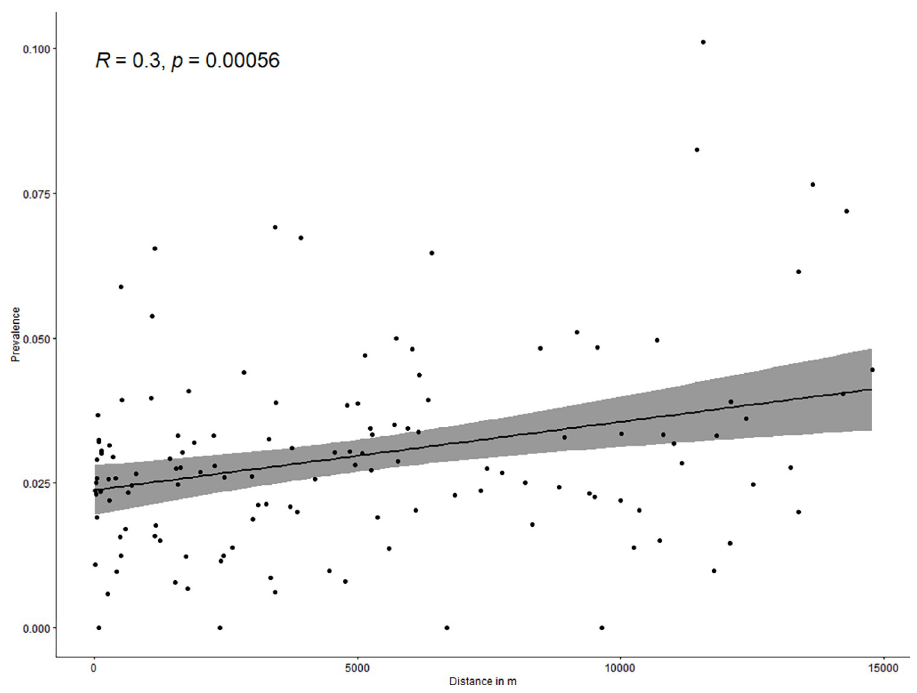
Fig 4. Scatterplot of distance to the closest main road and village seizure prevalence.